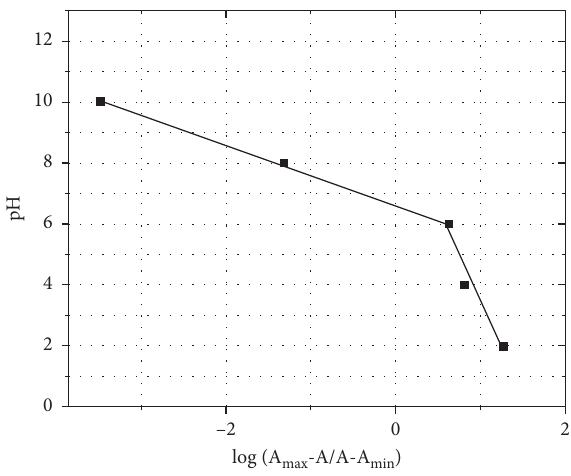
� 500nm) and excitation (left; ex